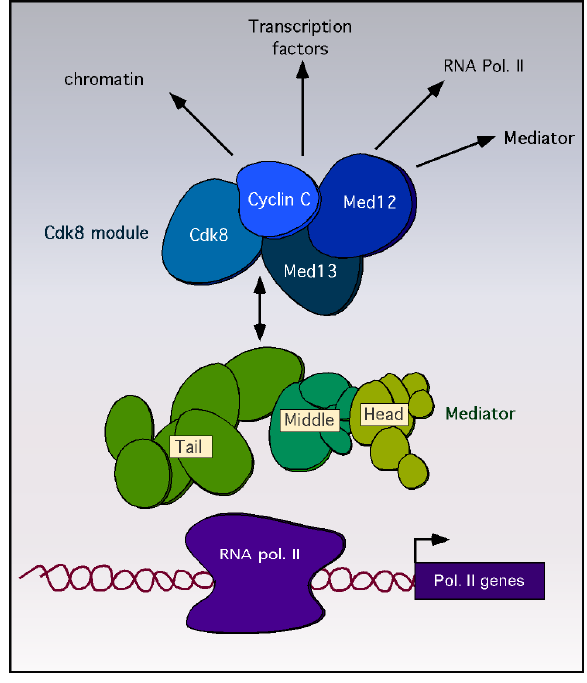
FIGURE 1: Diagram of the Mediator complex depicting the tar- gets of Cdk8 module regulation. Cartoon of the RNA polymerase II holoenzyme bound to DNA. The core mediator complex with the tail, middle and head regions are indicated. The Cdk8 module composed of cyclin C, Cdk8, Med12 and Med13 is indicated. Re- ported regulatory targets of cyclin C-Cdk8p are indicated by ar-